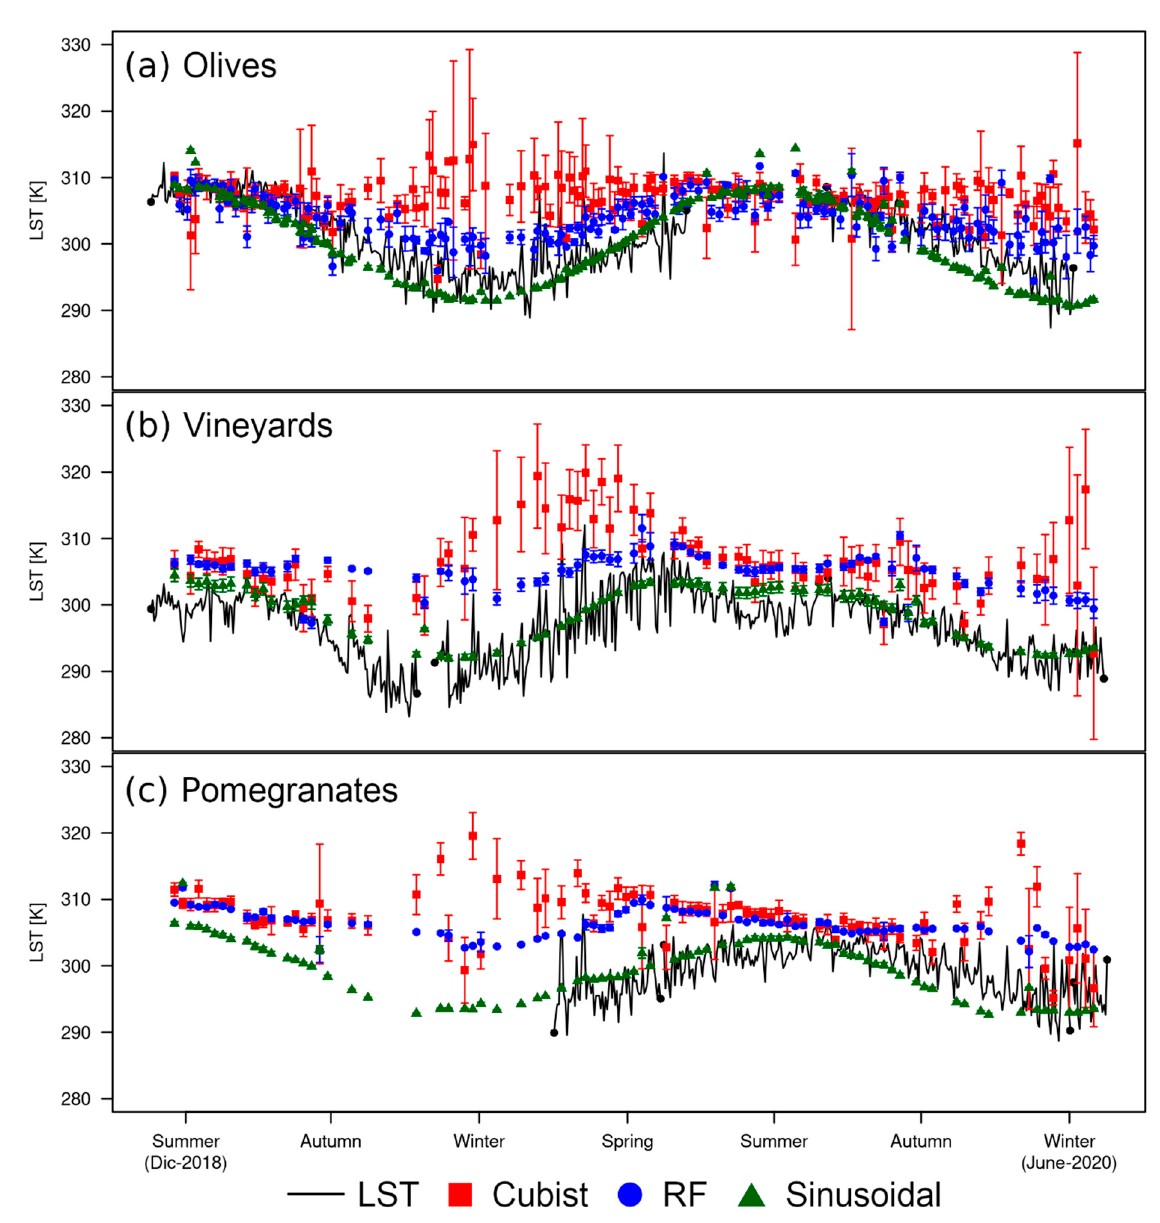
Figure 5. Temporal series of the predicted Sentinel-2 LST at 10 m of the cubist, random forest, and sinusoidal models versus the LST measured by the in situ stations at ( a ) olives, ( b ) vineyards, and ( c ) pomegranates orchards. The error bars are showing the standard deviation of the 9 pixel cells surrounding the LST station of each LST model.